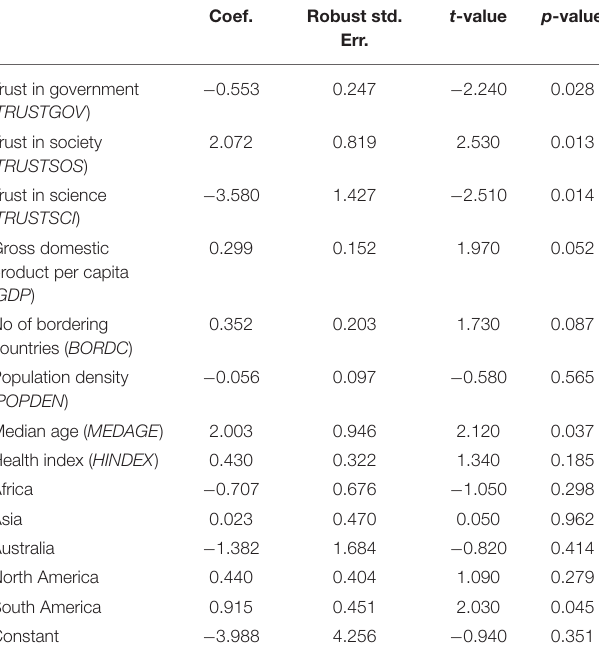
TABLE 2 | COVID-19 deaths per million people: Regression results. Coef. Robust std.